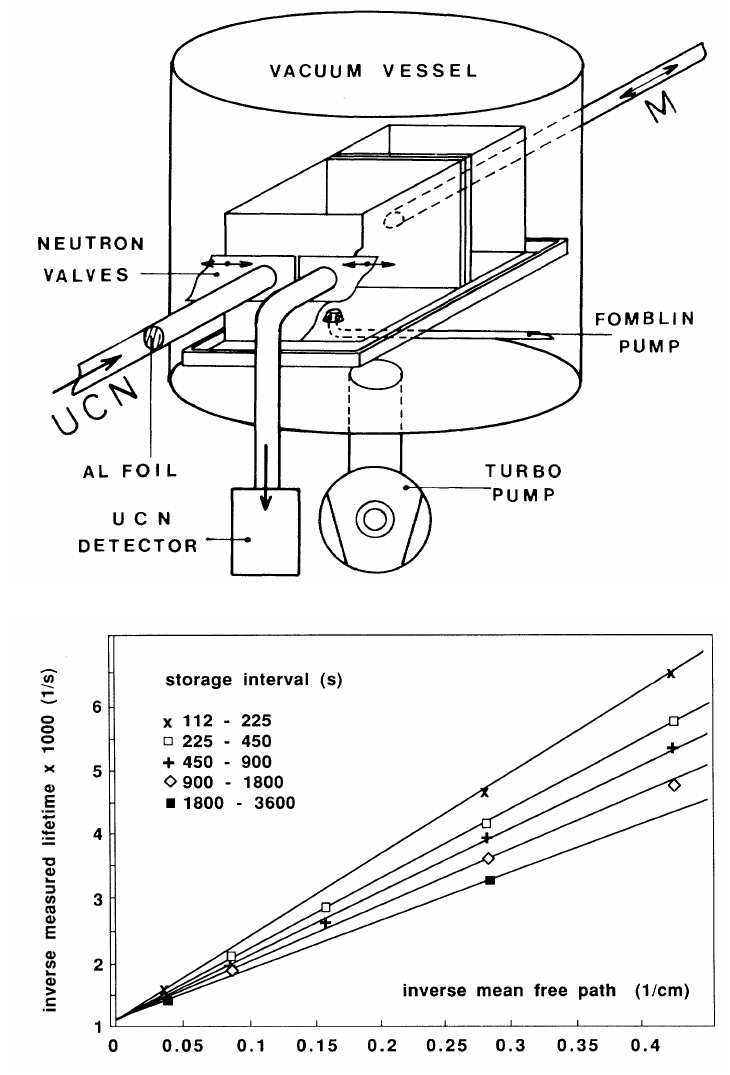
Figure 4. ( Top ): The ultracold neutron bottle used in the first MAMBO experiment [35]. Neutrons entered through the straight tube in front during the fill phase and exited through the bent tube during the counting phase. The rear wall could be moved using rod M to change the volume to surface ratio of the bottle and thereby control the wall loss rate. ( Bottom ): Data from the first MAMBO experiment; the measured inverse bottle lifetimes as a function of bottle inverse mean free path, for different storage intervals corresponding to different positions of the rear wall. The data extrapolate to a single point at zero inverse mean free path (infinite volume to surface ratio), where the wall loss rate is zero in principle, giving the neutron beta decay